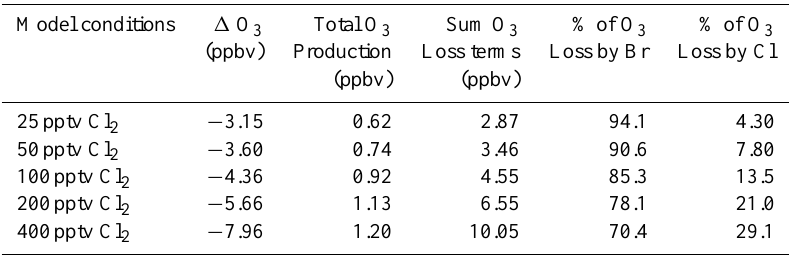
Table 7. Fraction of ozone depleted by bromine and chlorine calculated for mid-day of 29 March via Eq. (4) for modeling scenarios performed by varying Cl 2 mole ratios.